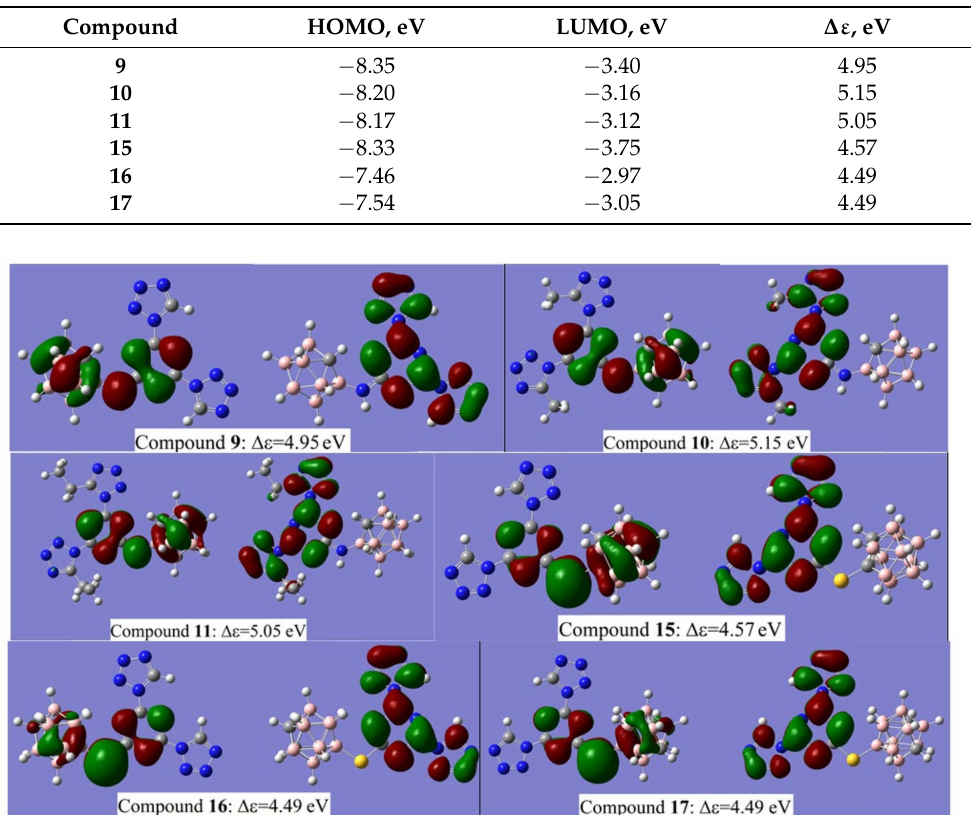
Table 2. Computed HOMO and LUMO energies and the frontier molecular orbital energy gap values for compounds 9 – 11 and 15 – 17 in gas phase.